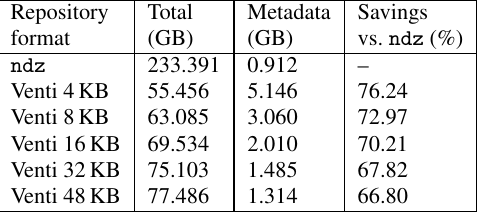
Table 3: Total storage space required for storing images in different repository formats, including metadata. ndz is for baseline Frisbee images stored in a